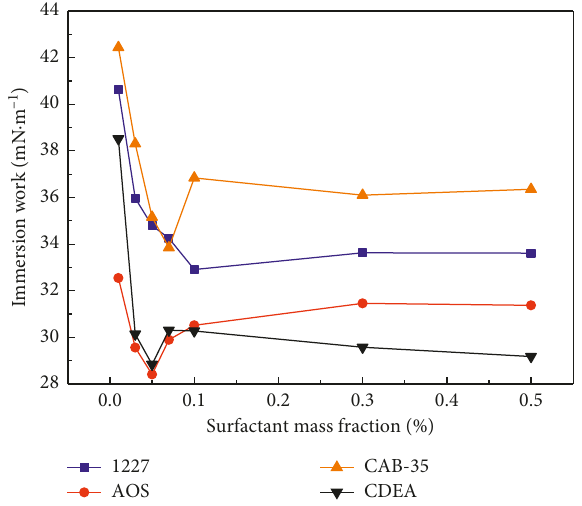
Figure 8: The immersion works of the surfactant solutions on the coal dust surface at the different